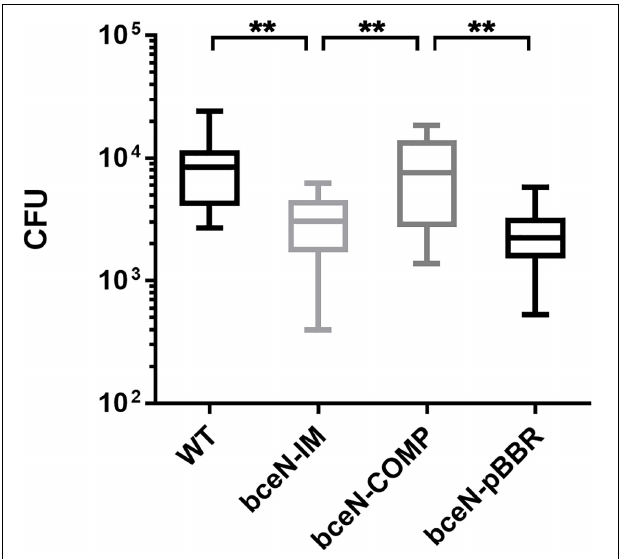
FIGURE 6 | The P. phymatum bceN mutant is less efficient than the wild-type and the complemented strain in attaching to bean roots. Numbers of bacterial cells attached to bean roots after 4-h incubation followed by two stringent washing steps to remove loosely attached cells. Shown are five independent experiments with one biological replicate of each strain, n = 13. CFU, colony forming units. Error bars indicate the standard error of the mean (SEM). WT vs bceN -IM, ** p = 0.0024; WT vs bceN -COMP, p = 0.8473; WT vs bceN -pBBR, ** p = 0.0020; bceN-IM vs bceN -COMP, ** p = 0.0040; bceN -COMP vs bceN -pBBR, ** p =